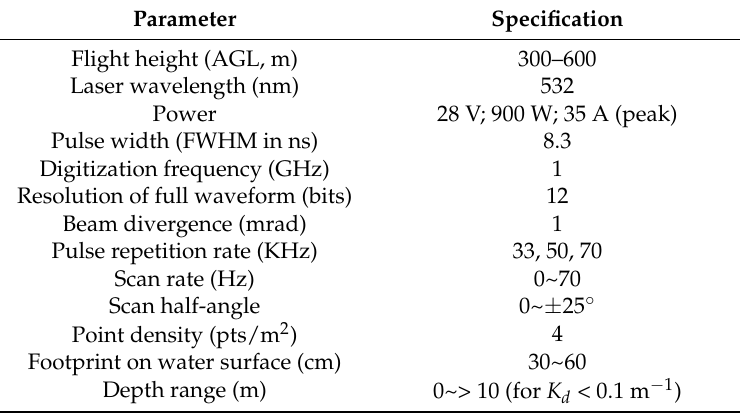
Table 2. Main technical characteristics of Aquarius in shallow water